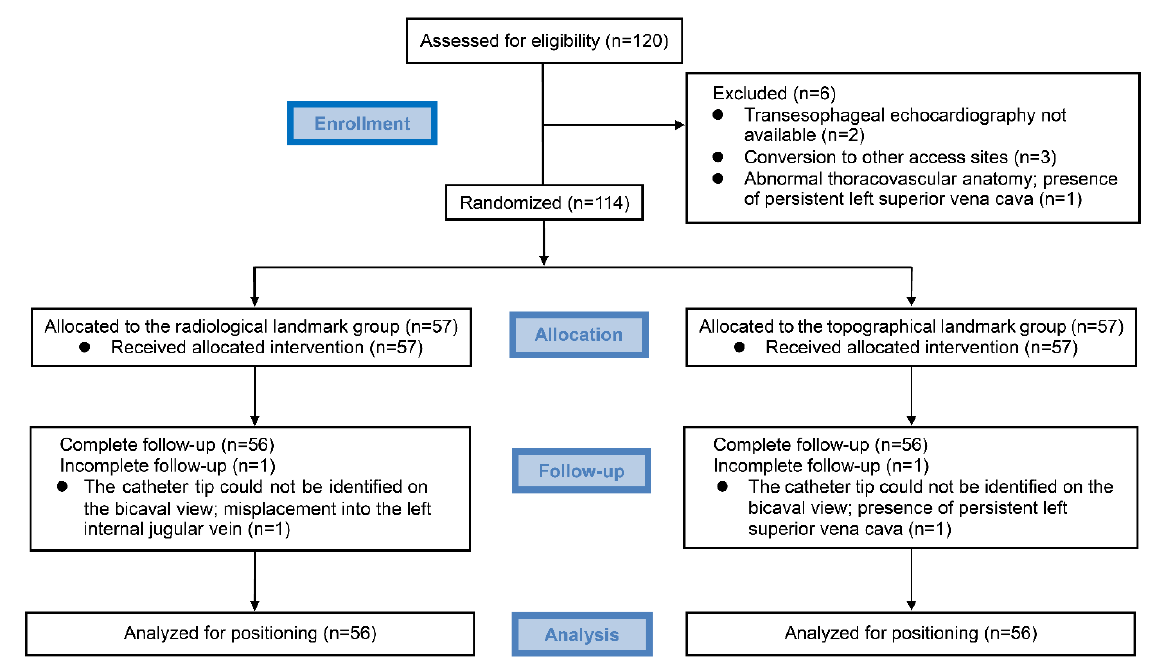
Figure 3. Consolidated Standards of Reporting Trials (CONSORT) flow diagram for participants included in the study.